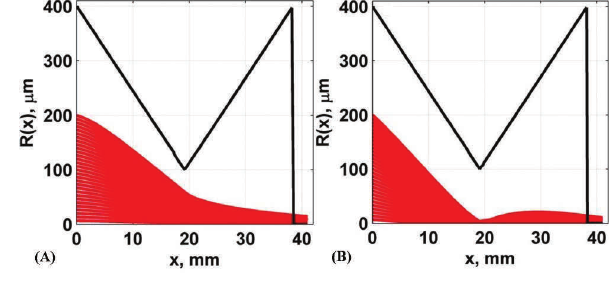
Figure 8. Simulation of the trajectory of 2 µm silver par- ticles through a converging-diverging nozzle with (A) Stokes force and (B) both Stokes and Saffman forces act- ing on the particles.